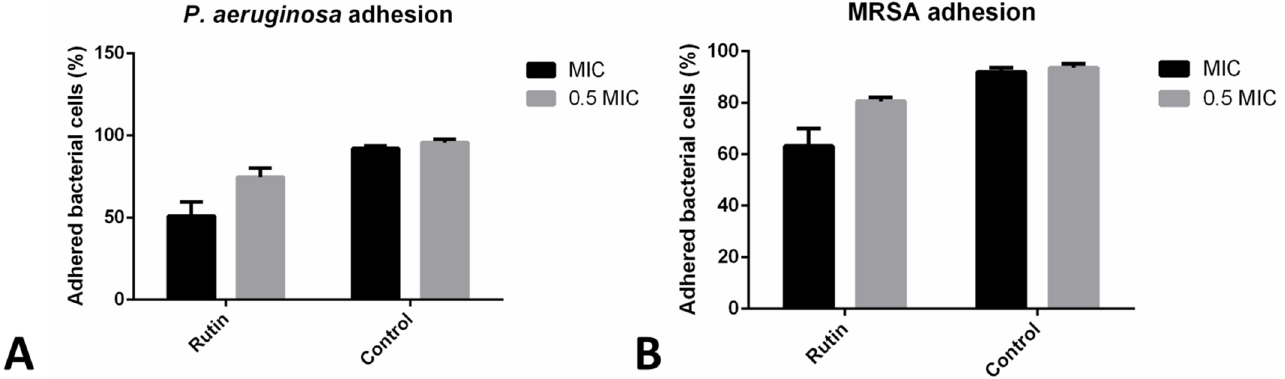
Figure 3. P. aeruginosa IBRS P001 ( A ) and MRSA IBRS MRSA011 ( B ) adhesion to HaCaT cells upon treatments with rutin (%). The data are presented as mean ± SD.